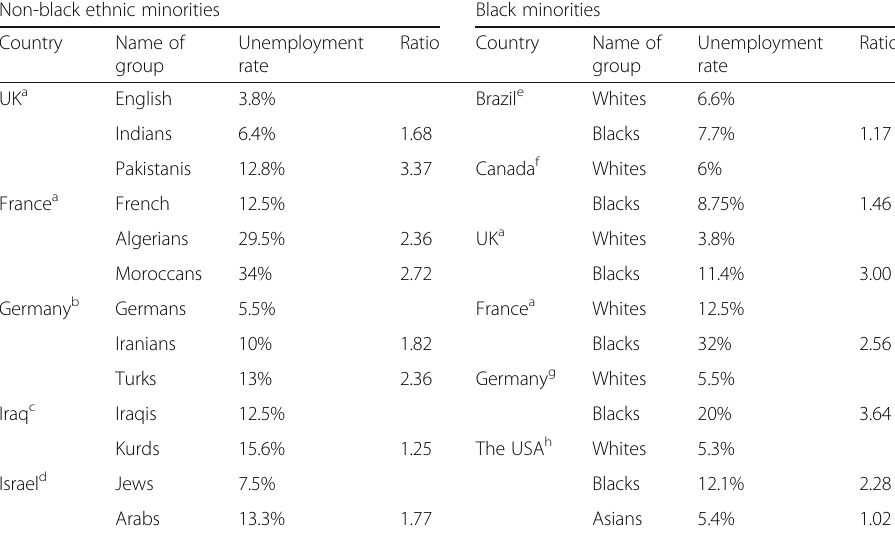
Table 6 Unemployment rates in source countries, minorities vs. majority groups Non-black ethnic minorities Black minorities